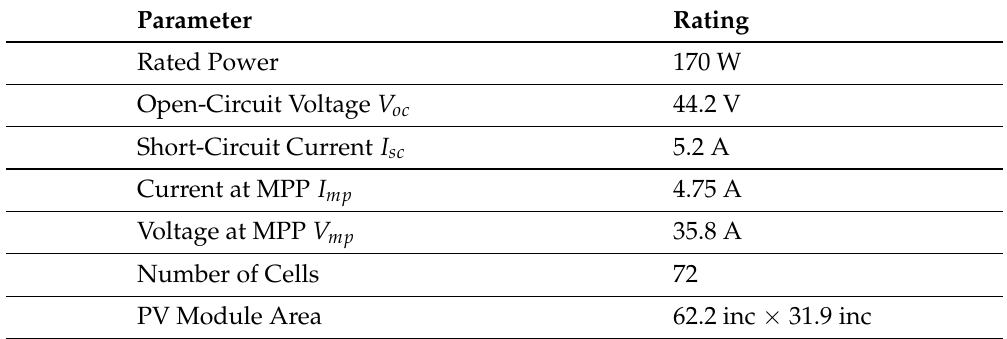
Table 1. The Parameters of PV module.